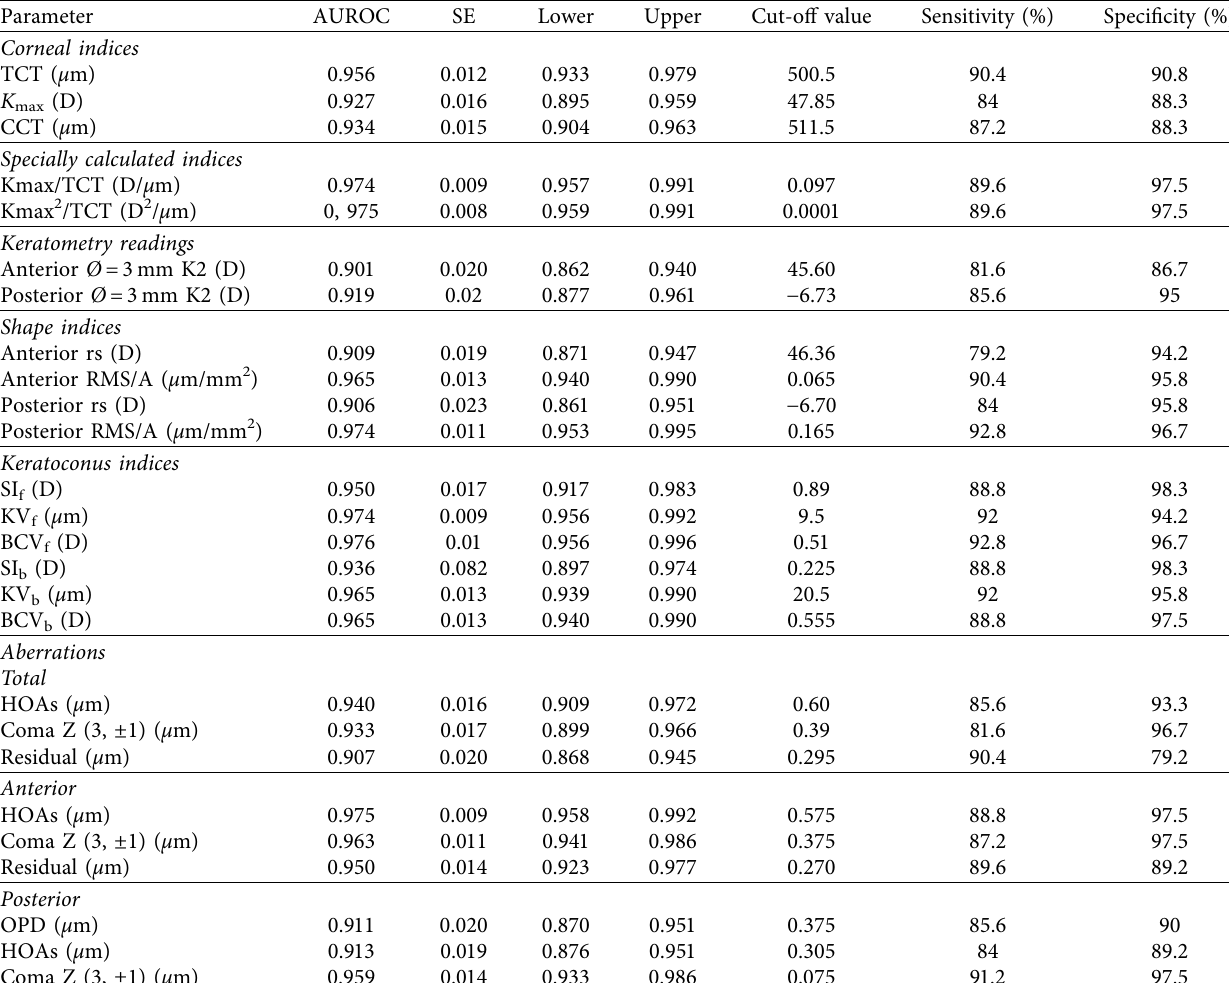
Table 4: Receiver operating characteristic (ROC) analysis of the parameters where AUROC values are greater than 0.9 95% confidence